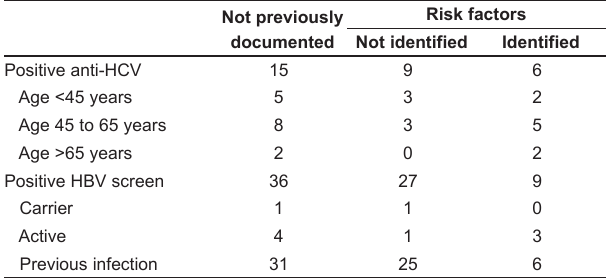
TAble 2 Incidence and demographics of patients with